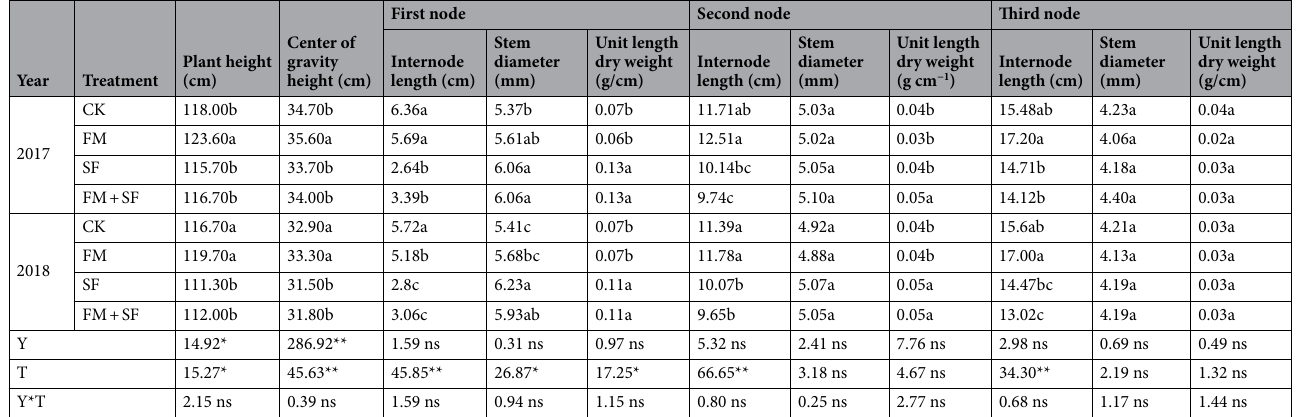
Table 5. Effects of bast fiber film and nano-silicon fertilizer treatments on lodging resistance traits in rice. Different letters indicate significant difference at 5% level. Summary of ANOVA results: not significant (ns), significant at p < 0.05 (*), very significant at p < 0.01 (**). Y Year, T Treatment.